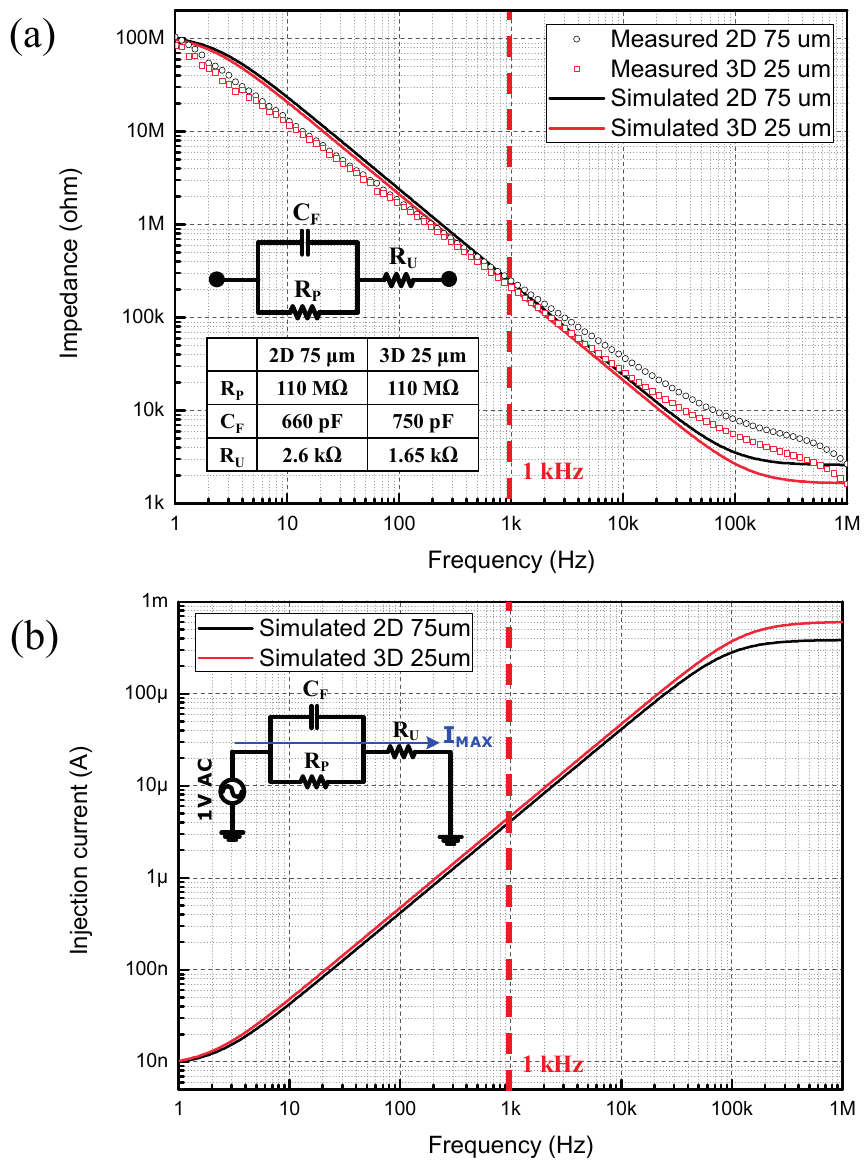
Figure 3. Electrical properties of 2D and 3D Au microelectrodes. ( a ) Measured interface impedance results (red and black circles) and parameterized interface impedance results using three-element-circuit model (red and black lines); ( b ) Theoretical current injection limit derived from three-element-circuit model using SPICE (at bias voltage 1